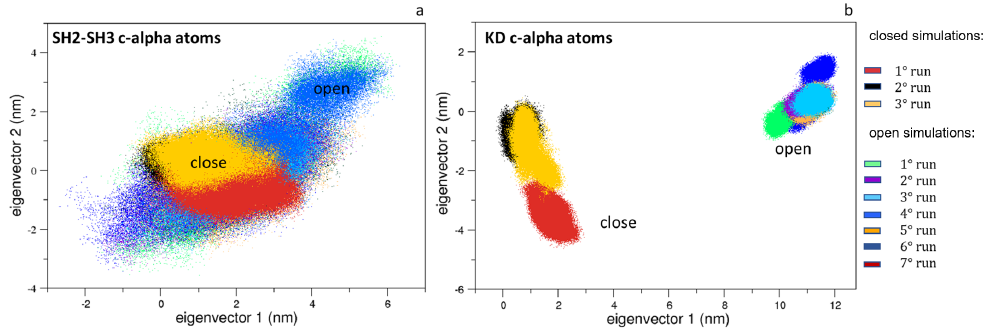
Figure 4. The 2D trajectory projections on the Src domain’s common conformational space. In panel ( a ) is the SH2-SH3 domain projections along the first two eigenvectors; in panel ( b ) is the KD projections along the first two eigenvectors. The projections for the closed and the open states are labeled.